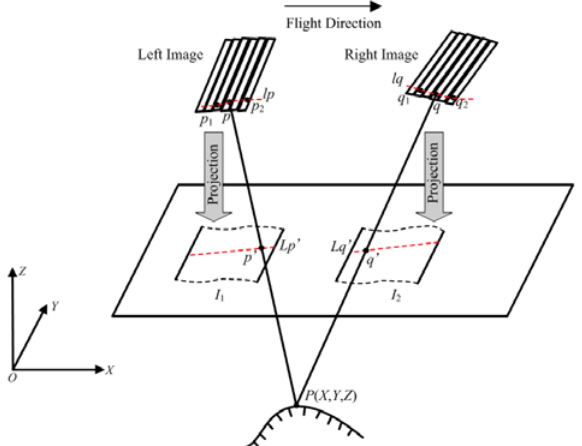
Figure 2. Epipolar resampling of linear pushbroom imagery based on virtual horizontal